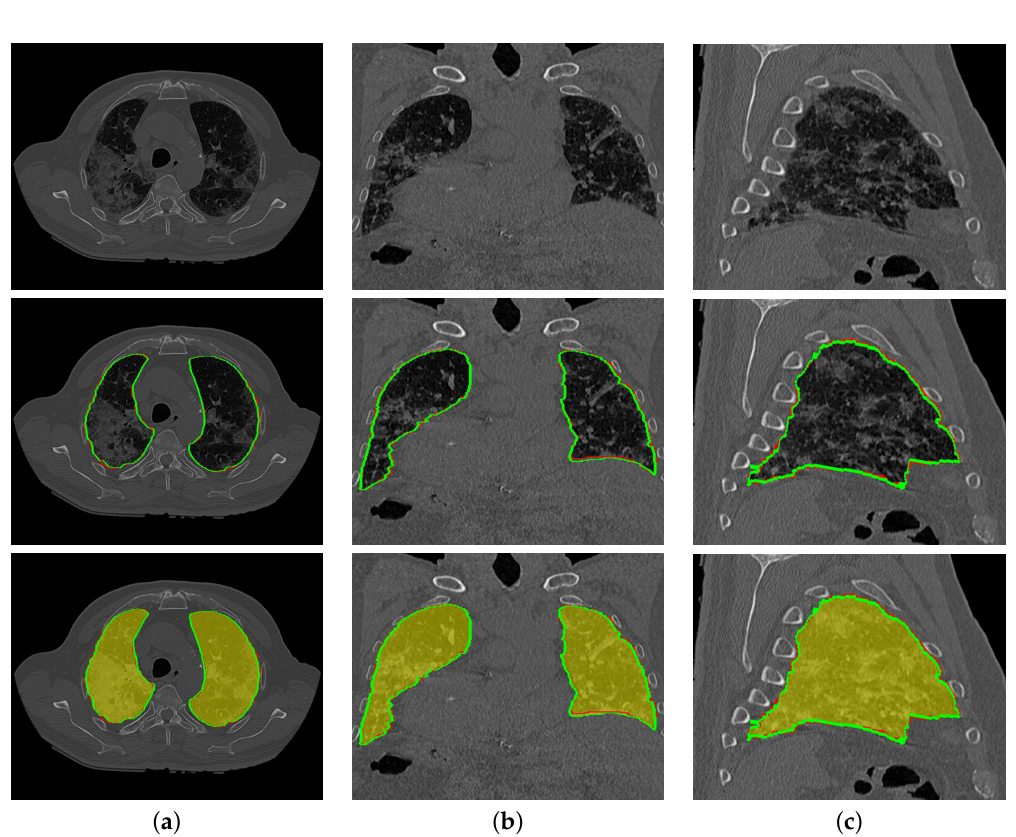
Figure 9. An illustrative example of the proposed segmentation (second and third rows) for a severe COVID-19 infected lung at ( a ) 2D axial, ( b ) coronal, and ( c ) sagittal cross sections of an original image (first row). Note that red border (green border or yellow region) refers to ground-truth